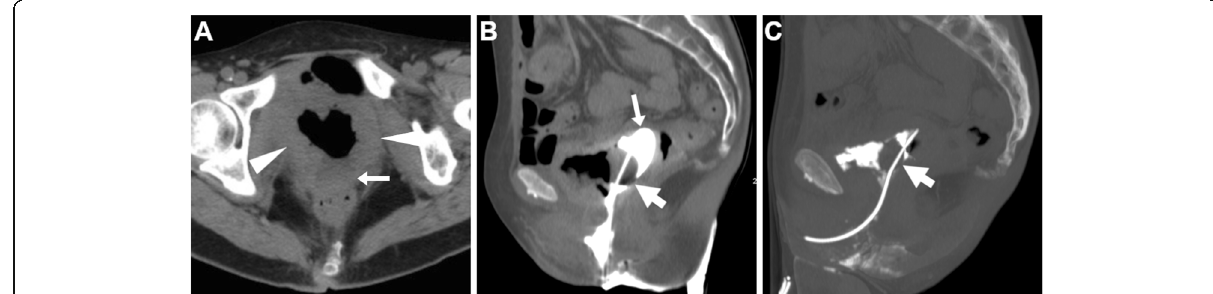
Fig. 4 CT-vaginography in a patient with advanced bladder and urethral undifferentiated carcinoma invading the vagina, seen as marked circumferential mural thickening (arrowheads in precontrast CT a ). After introduction and inflation of the Foley catheter (thick arrows) in the vagina, injection of CM medium allows opacification and distension of the vagina (arrow at vaginal dome in b ) and subsequent CM flow anteriorly into the urinary bladder (in c